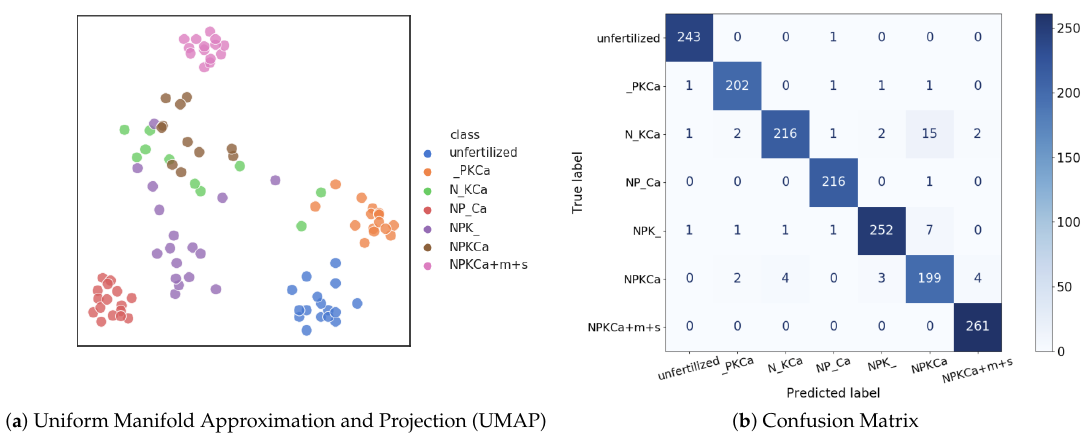
Figure 9. ( a ) UMAP result with the features extracted from DenseNet-161 before the last FC layer. 100 samples are randomly chosen for simplification. ( b ) Confusion matrix for